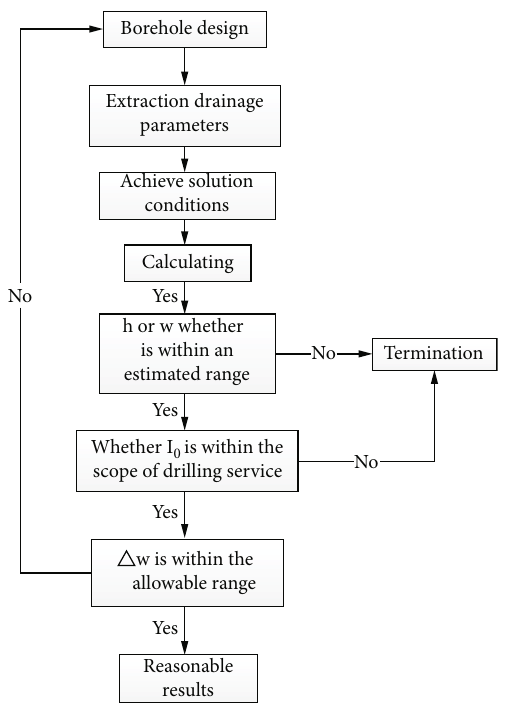
Figure 4: The fl ow chart of inspection and